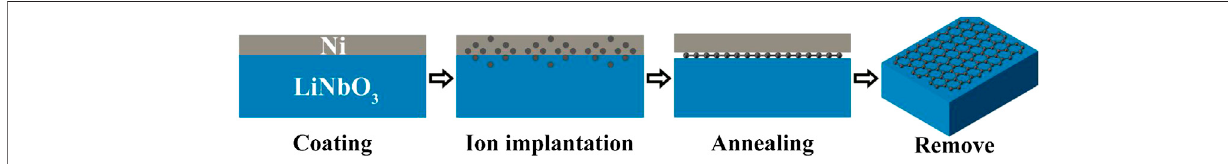
FIGURE 1 | A schematic diagram of the steps of the experiment.